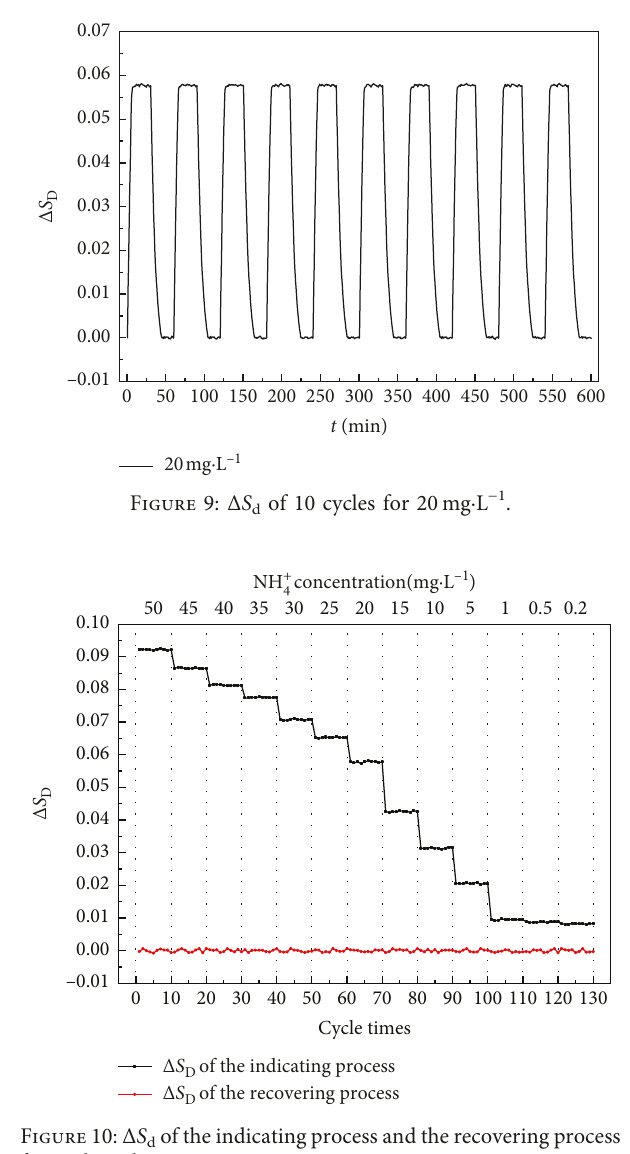
3 , and (c) after recovery in pure water environment.